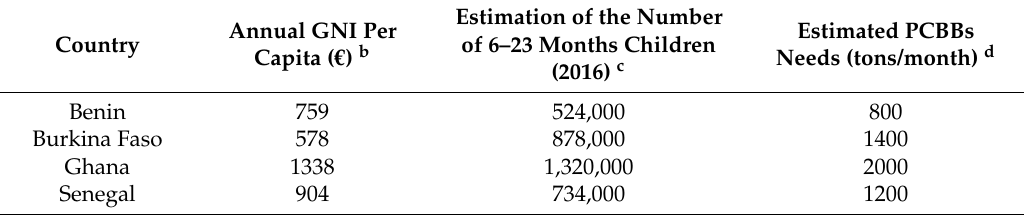
Table 1. Rough estimation of the monthly needs in fortified PCBBs a used as complementary foods in four West African